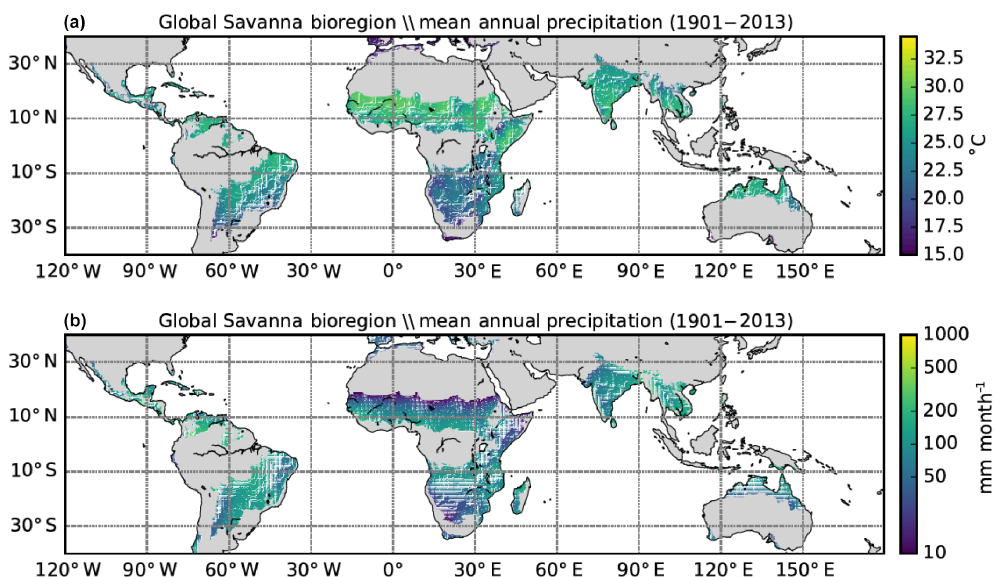
Figure 1. Global maps of (a) mean annual temperature and (b) mean annual rainfall for the period 1901 to 2015, determined from the CRU TS v. 3.23 dataset (Harris et al., 2014). The dataset has been clipped to the eco-floristic regions that approximate the global extent of savannas using the following plant functional types: tropical moist deciduous forest, tropical dry forest, sub-tropical dry forest and tropical shrubland (Ruesch and Gibbs,